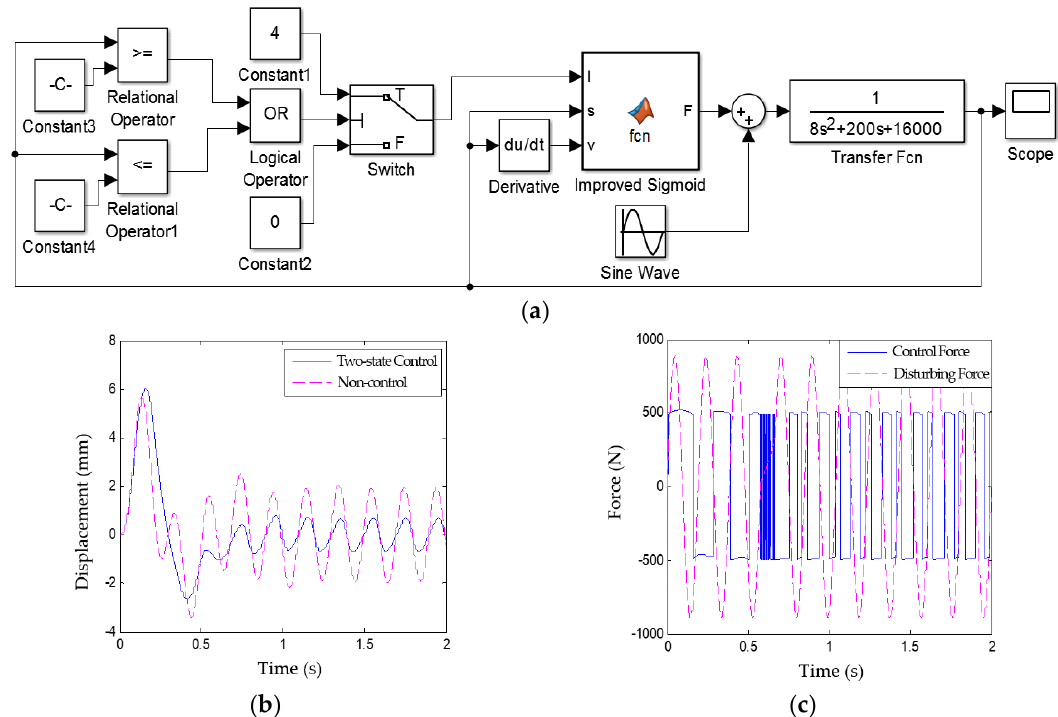
Figure 7. Simulation of two-state pipeline vibration control system with dead zone: ( a ) Two-state simulation model; ( b ) Vibration displacement response; ( c ) Control force and disturbance dynamics curve